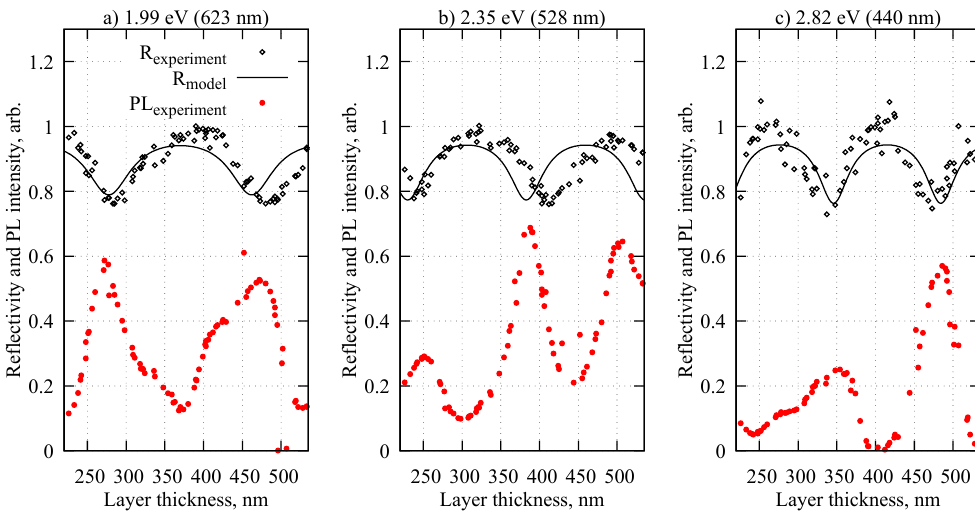
Figure 6. Coefficient of reflection and PL intensity (not to scale) depending on ZnO NR–PAAO hybrid film thickness recorded at specific wavelengths that correspond to ( a ) yellow, ( b ) green, and ( c ) blue components in reference spectrum of 35 nm ZnO on Al surface (see main